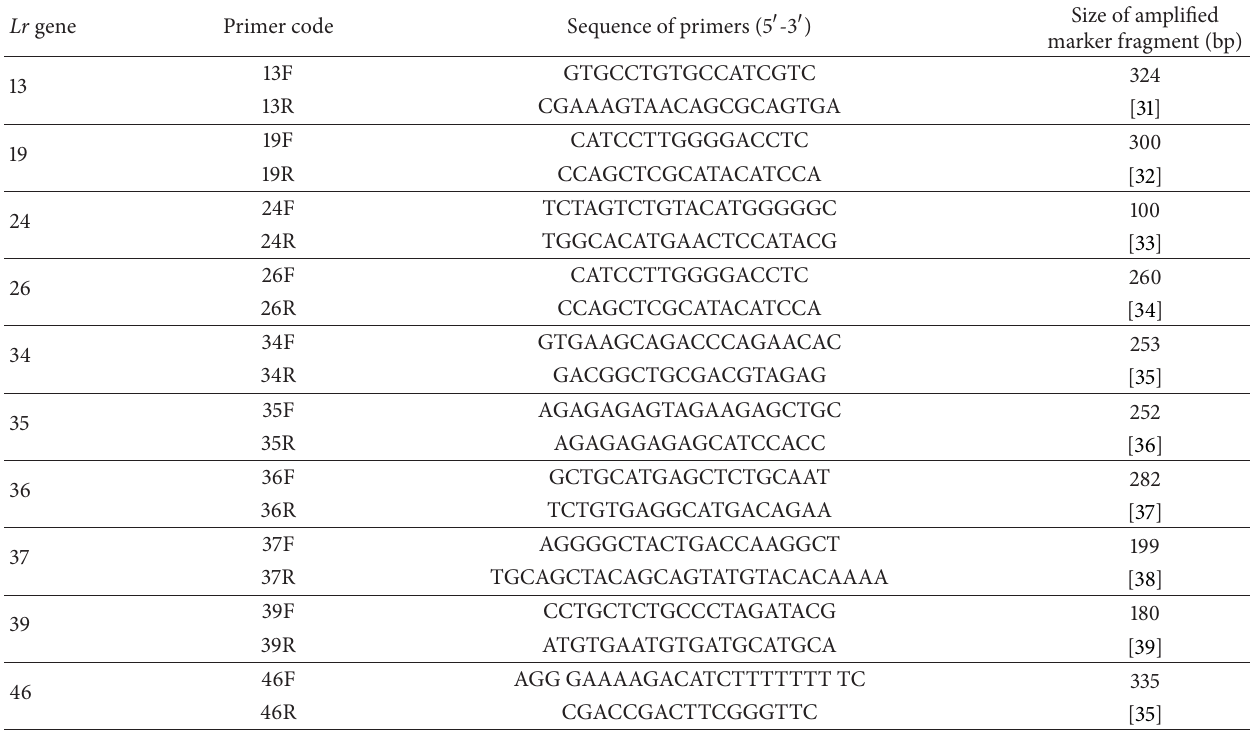
Table 1: Sequences of the nucleotide primers used in this study.